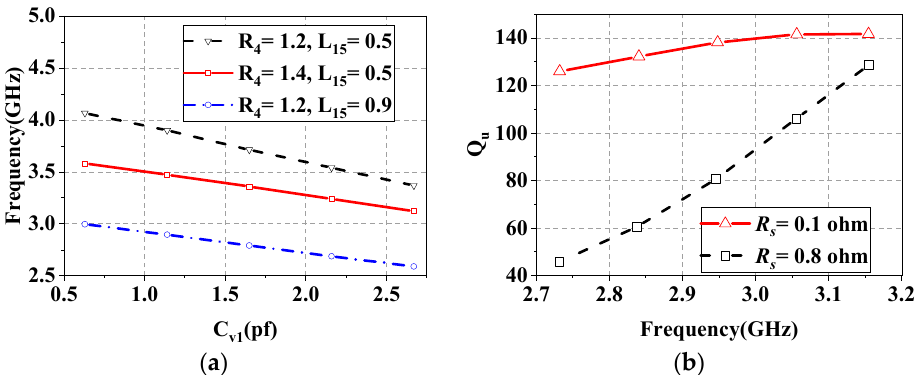
Figure 4. ( a ) The resonant frequency of resonators versus C v1 for different R 4 and L 15 . ( b ) Simulated Qu versus the resonant frequency; R s is the parasitic resistance of C v1 .